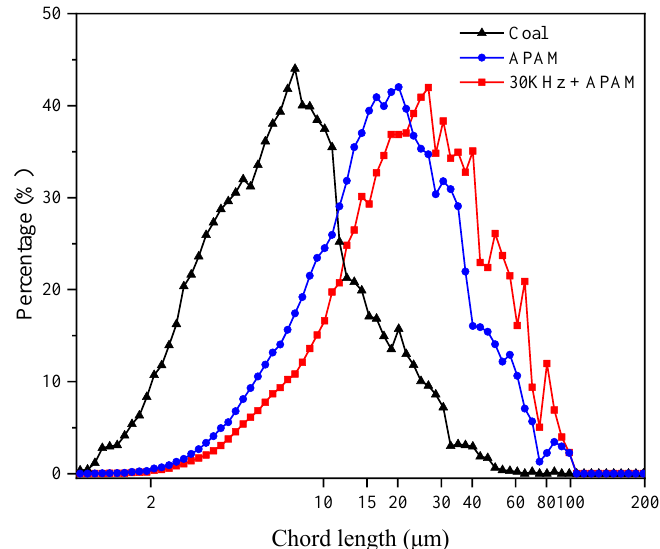
Figure 14. Results of the FBRM test on the chord length distribution of flocs under different condi- tions.